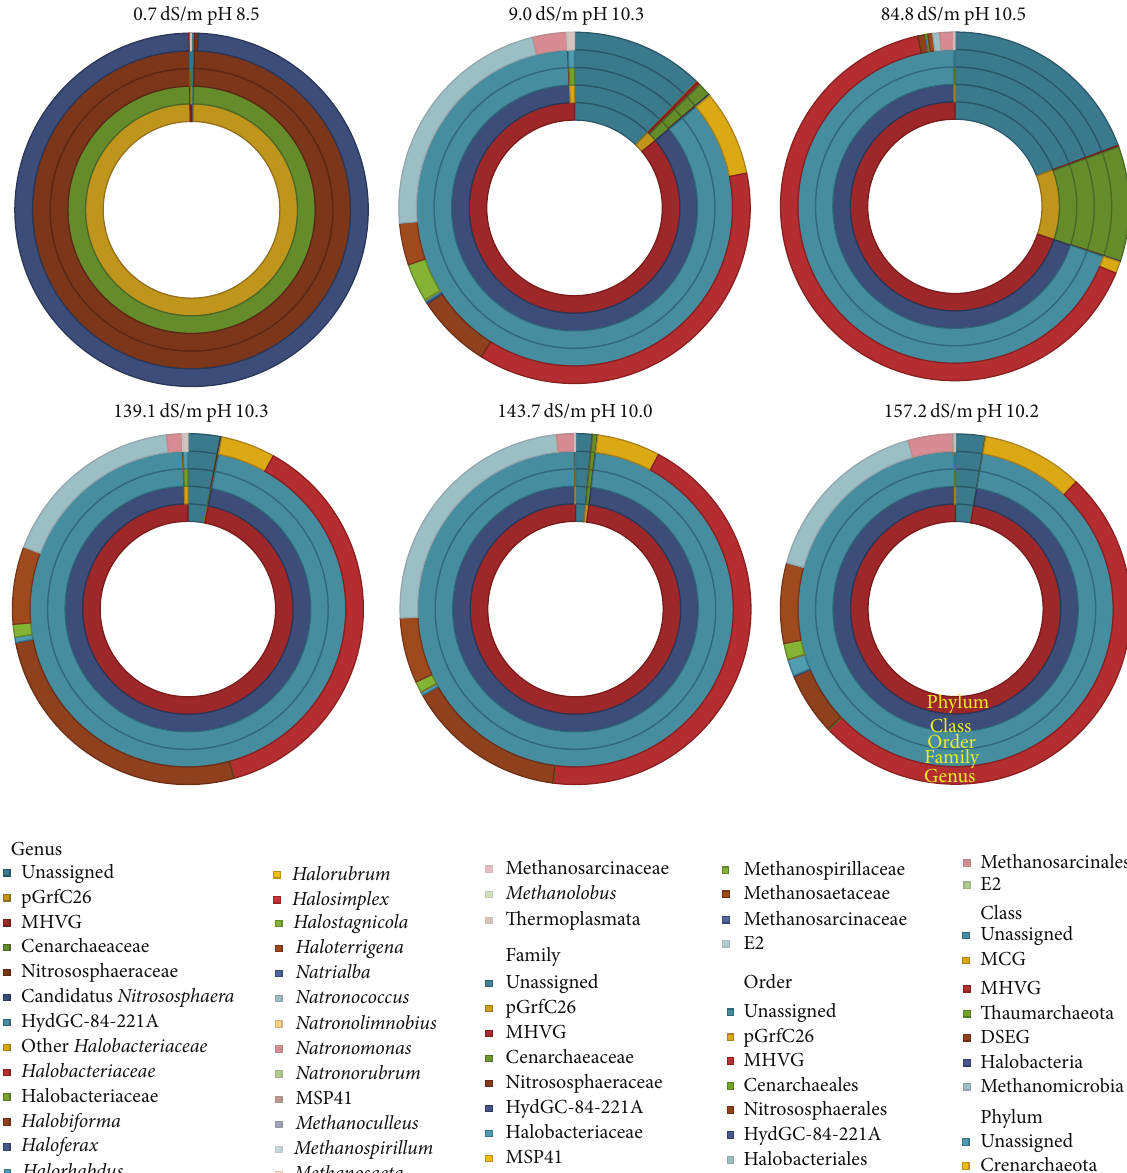
Figure 2: Taxonomic distribution at different ranks of the archaeal communities in alkaline-saline soils of the former lake Texcoco. Soils are different in electrolytic conductivity and